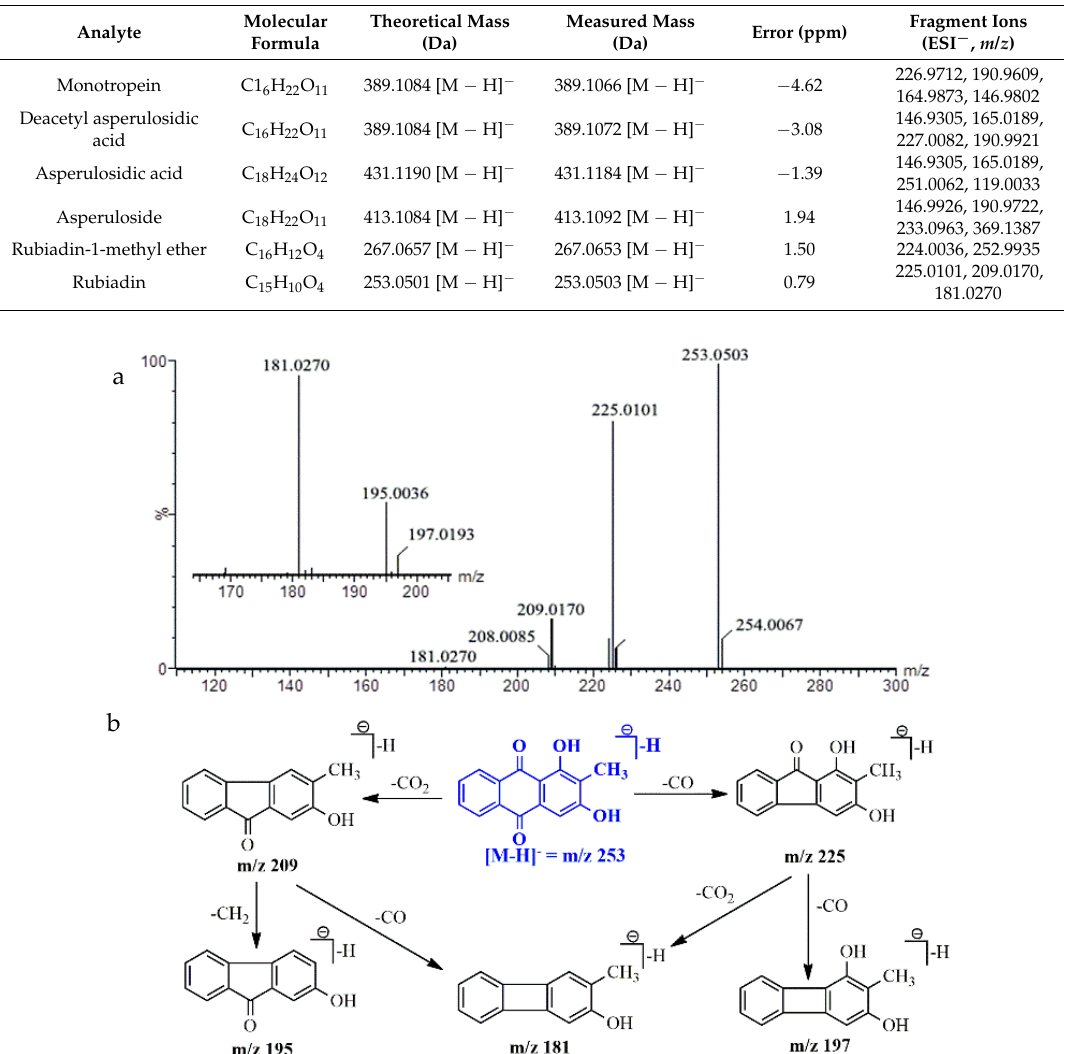
Table 5. Mass data of the six analytes from M. officinalis by UPLC-Q/TOF-MS.